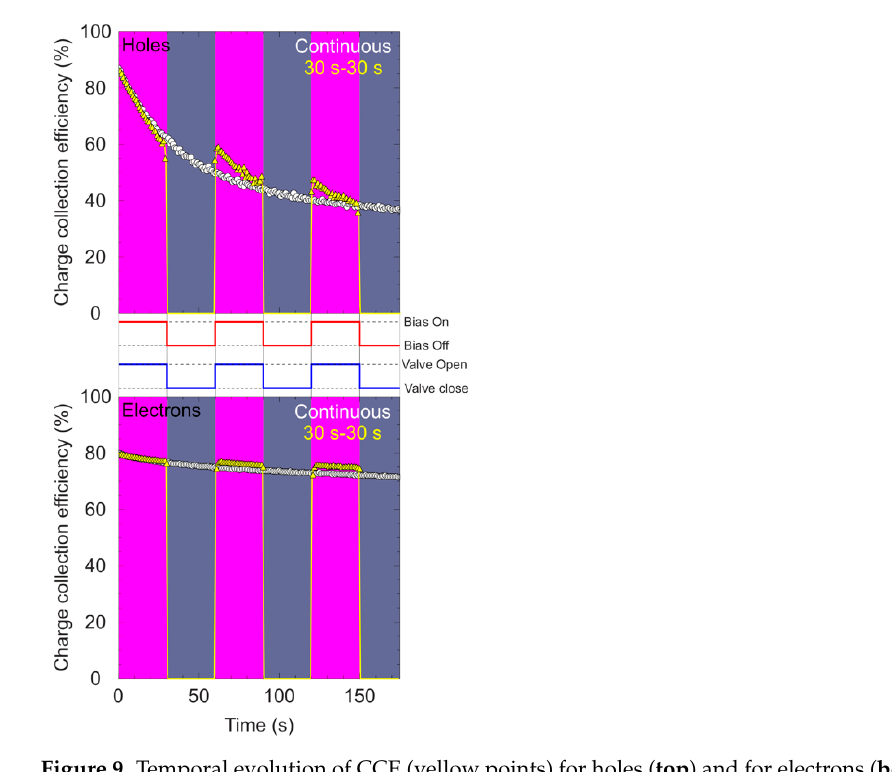
Figure 9. Temporal evolution of CCE (yellow points) for holes ( top ) and for electrons ( bottom ), while switching the bias and the beam on/off. The white points correspond to the case where the beam and the bias were on all the time. The detector was biased at ±12 V.